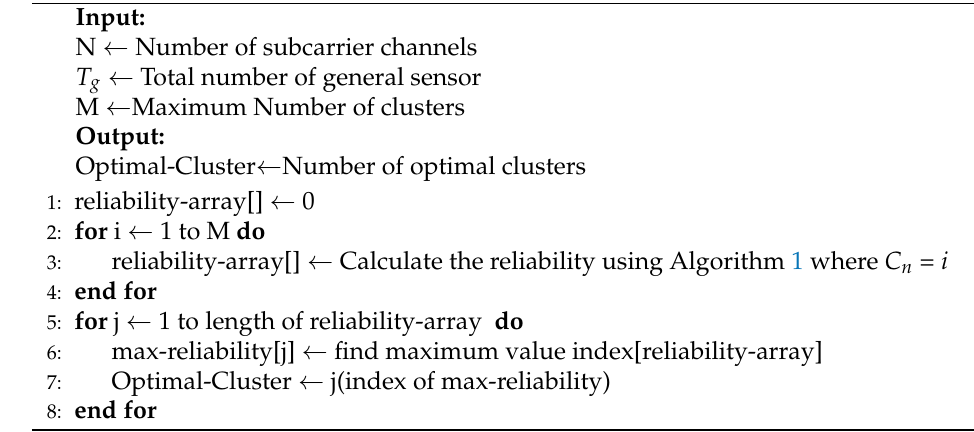
Algorithm 2 Optimal number of Cluster allocation